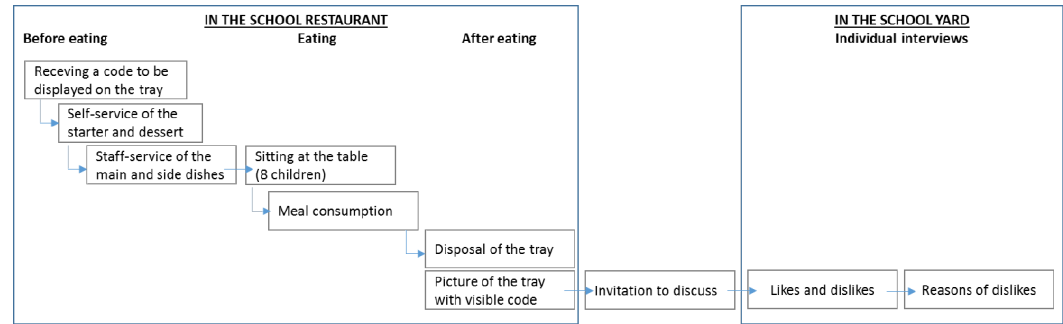
Figure 1. General scheme of the protocol with children.